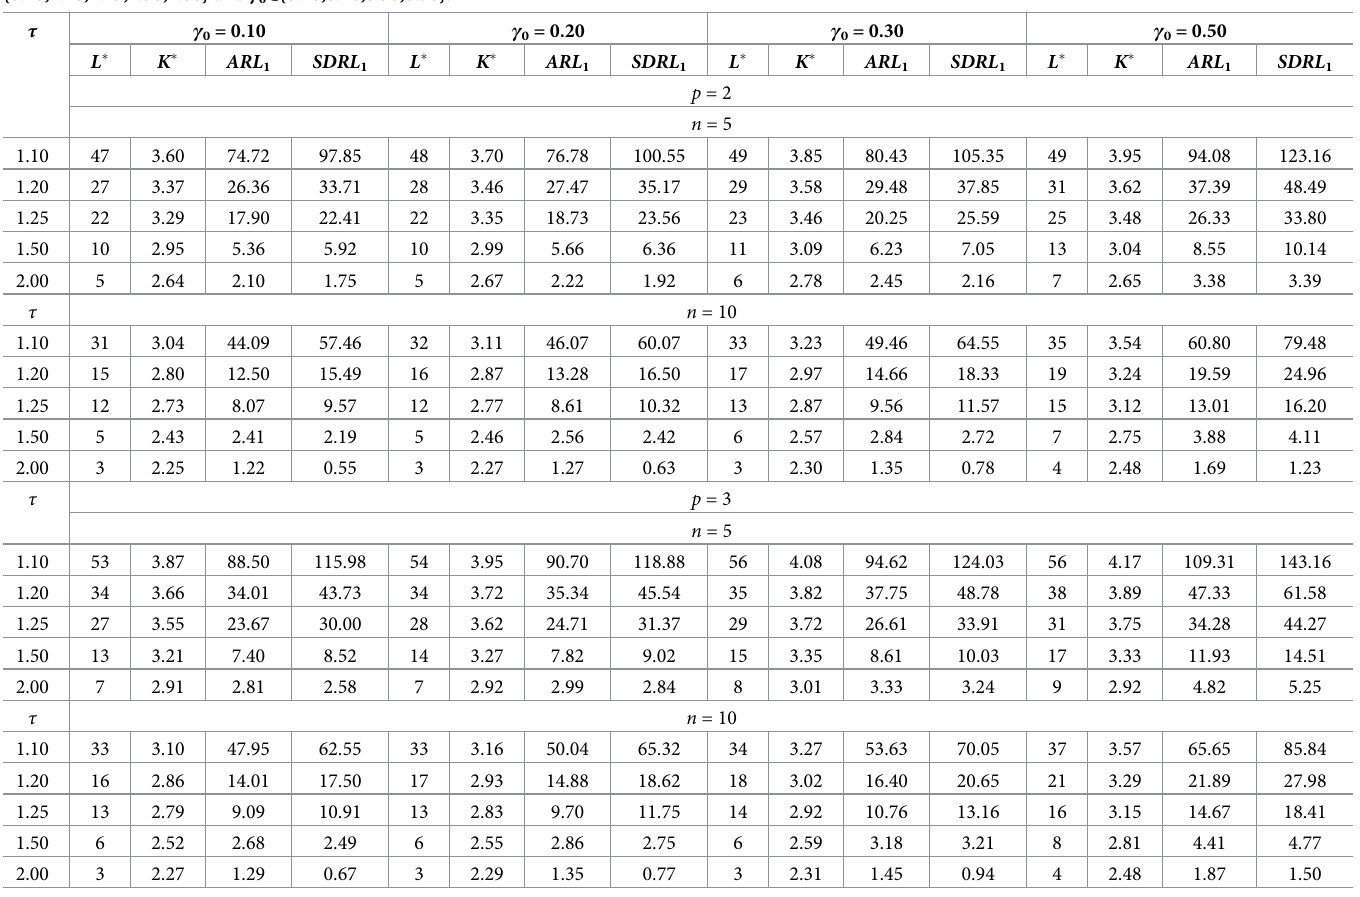
Table 2. Optimal charting parameters and the corresponding ARL1 and SDRL1 values of the multivariate SS Chart for p 2 {2,3}, n 2 {5,10}, τ 2 {0.10,1.20,1.25,1.50,2.00} and